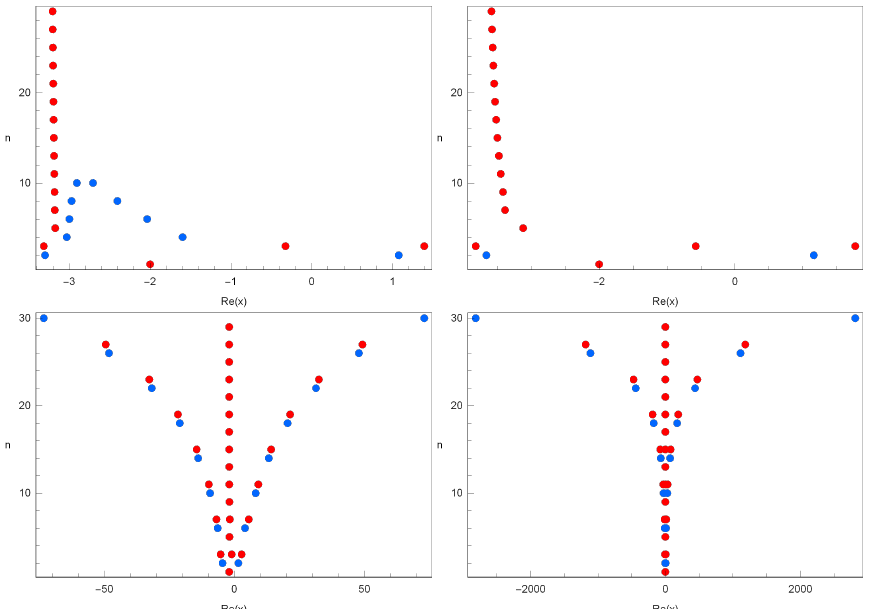
Figure 3. Stacking structure of approximation roots in ( p , q ) -cosine geometric polynomials when 1 ≤ n ≤ 30, p = 9